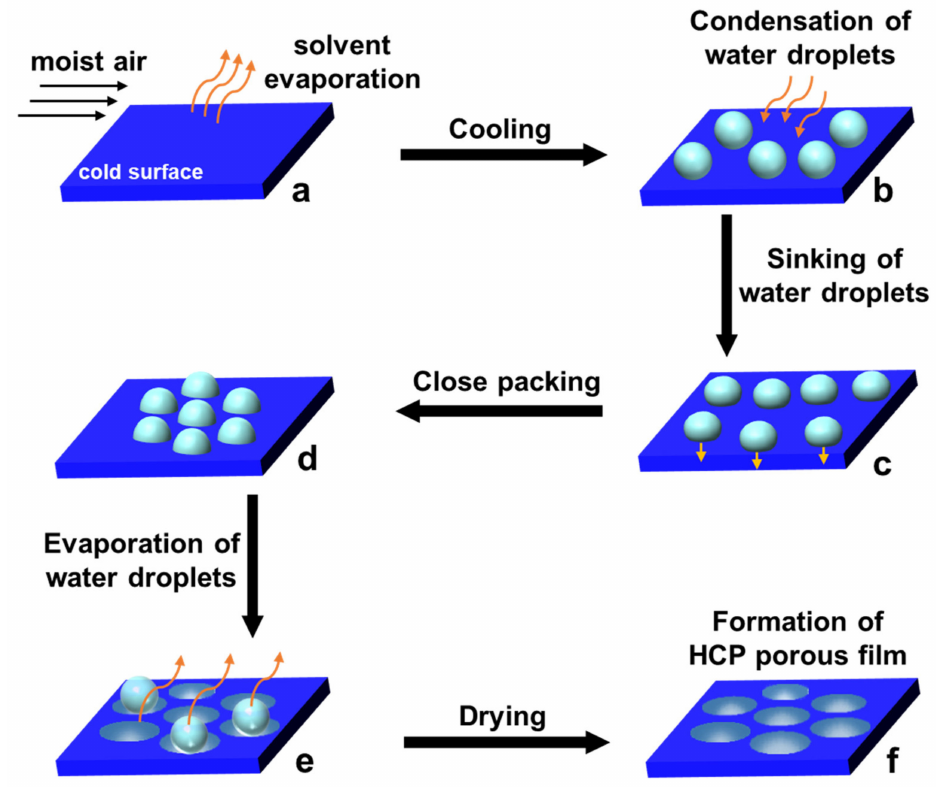
Figure 1. A sequence of stages for the preparation of HCP porous film by the breath-figure method. ( a ) Polymer solution in a volatile solvent under humid conditions; ( b ) condensation of water droplets due to cooling of surface temperature; ( c ) water droplets grow bigger and sink into the solution; ( d ) packing of water droplets; ( e ) arrangement of water droplets into ordered two- or three-dimensional (2D or 3D) arrays; and ( f ) formation of HCP film after